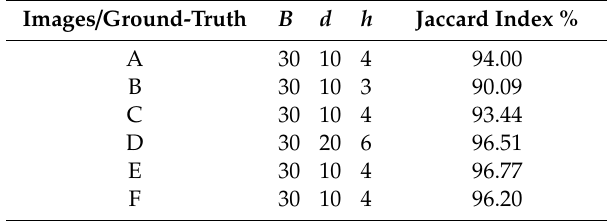
Table3. Table 3. Jaccard index obtained between the results of the proposed method and the ground truth images.